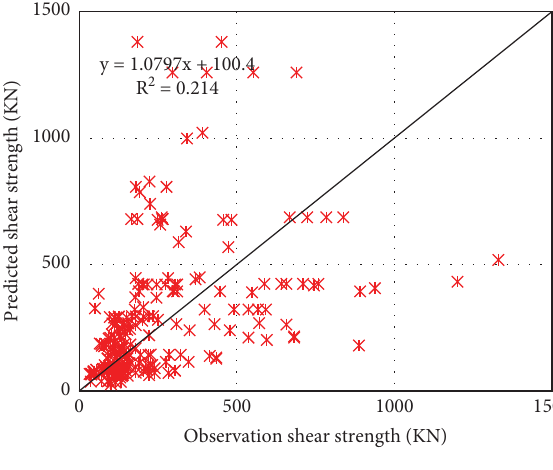
Figure 12: Target (experimental) versus predicted values of shear strength for ACI-318 model using all